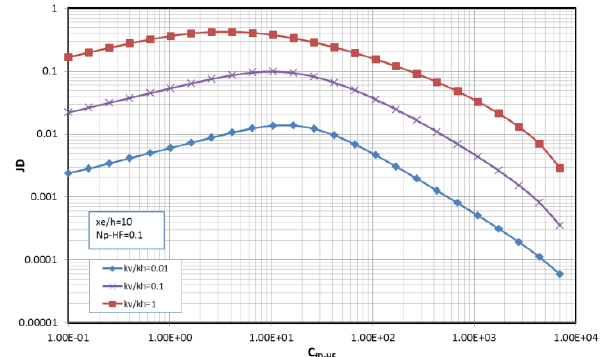
Figure 6—Sensitivity Analysis with varying k